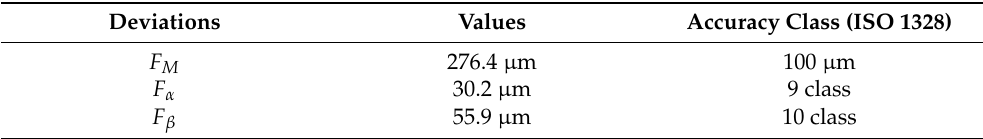
Table 1. Accuracy class of cold extruded teeth.